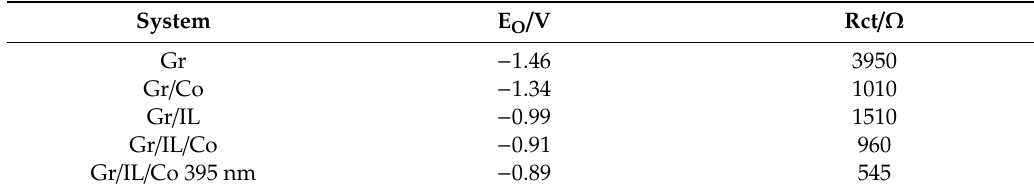
Table 2. Onset potential (*E O ) and charge transfer resistance (Rct) values.